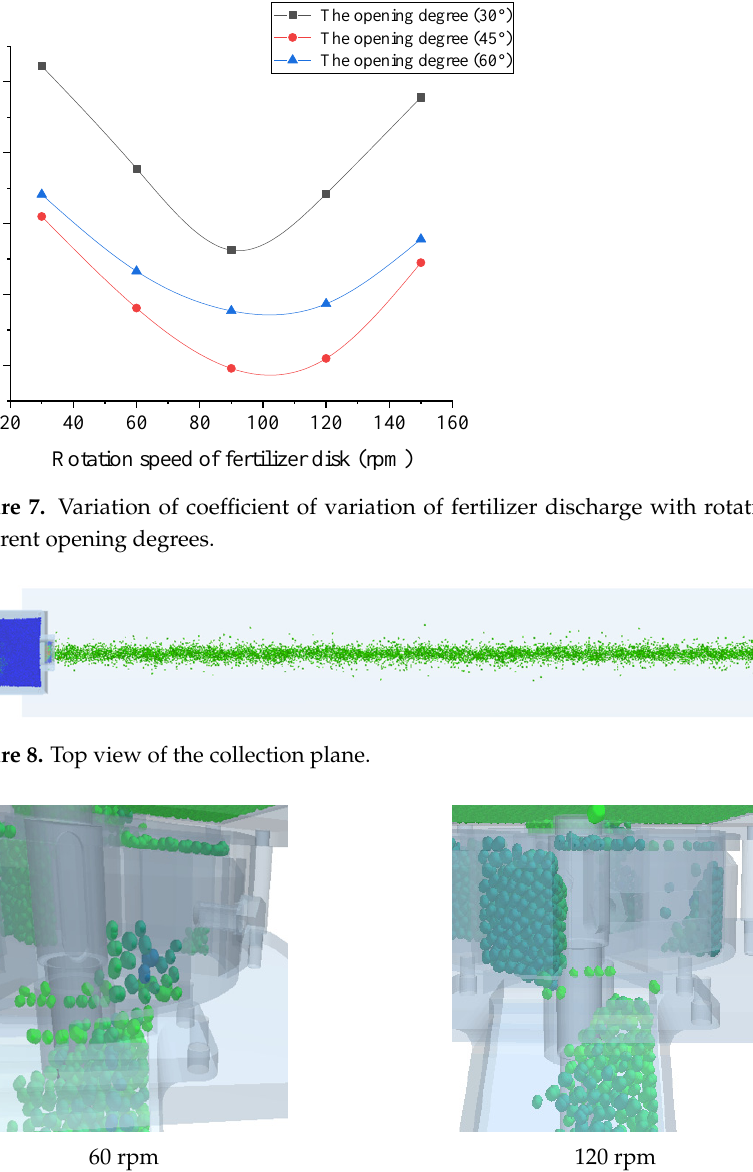
Figure 9. Particles remaining in the cavity after rotation speeds of 60 rpm ( left image ) and 120 rpm ( right image ).